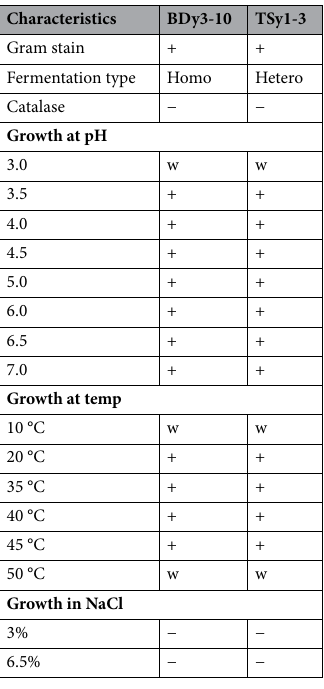
Table 4. Physiological and biochemical characteristics of LAB. + positive. − negative. w weakly positive, Homo homofermentative, Hetero heterofermentative.